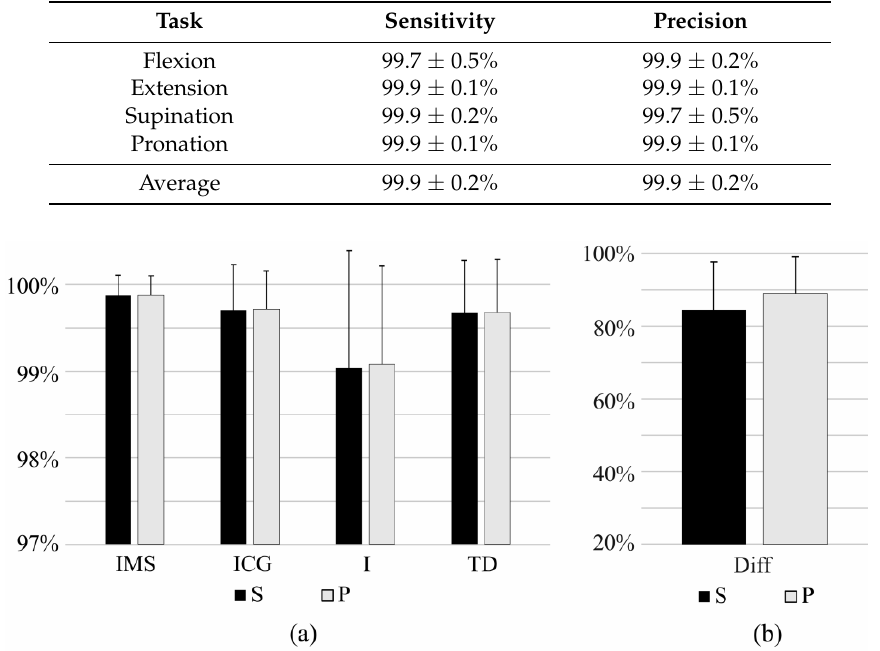
Figure 6. Sensitivity (S) and precision (P) of short-term identification of task using ( a ) IMS, ICG, I, and TD features, and ( b ) using Diff features. Results of the identification using Diff is showed in a different scale. Table 2. Sensitivity and precision of identification of task and effort level averaged between patients. Identification indices for each patient were calculated as an average of hold-out repetitions (N = 20) and presented in terms of mean and standard